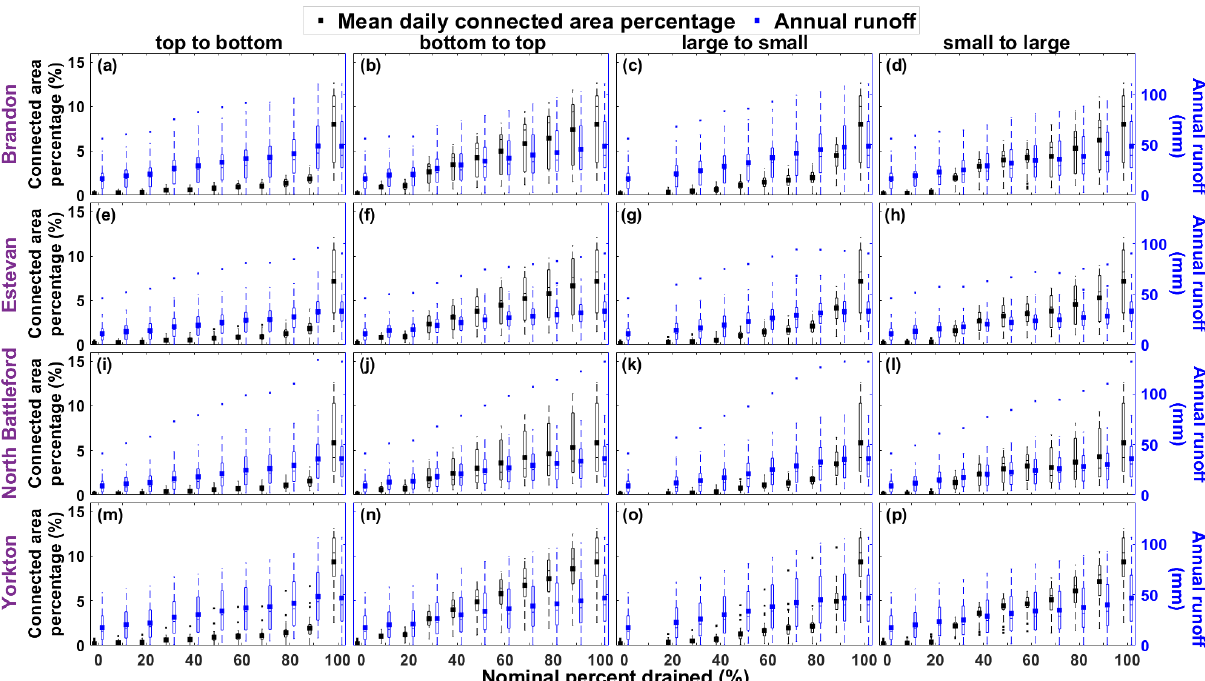
Figure 5. Box plots of annual runoff depth (mm; blue) and annual maximum connected area percentage (black) for baseline (0% drainage) and four drainage pattern scenarios for each of the four climates for the period of simulation